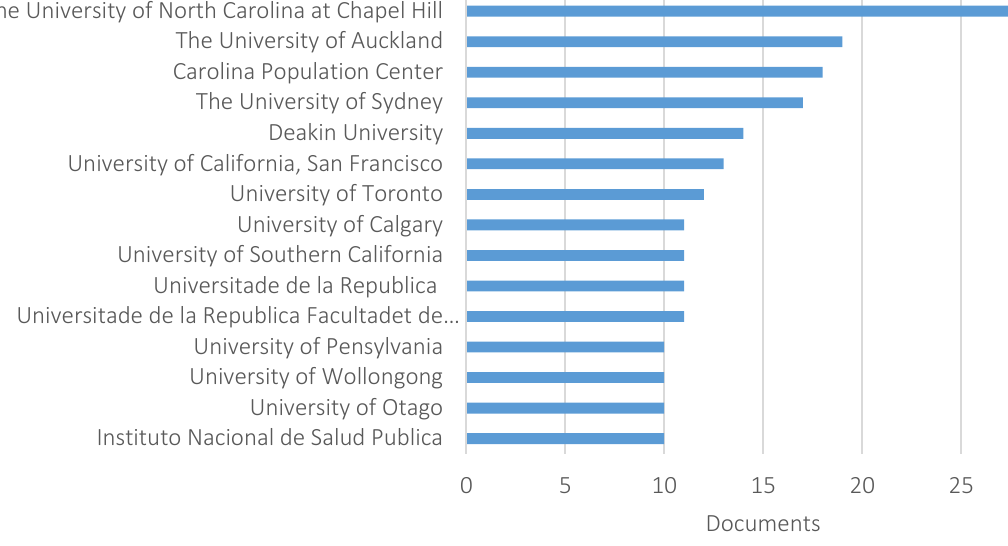
Figure 3. Top 15 most productive